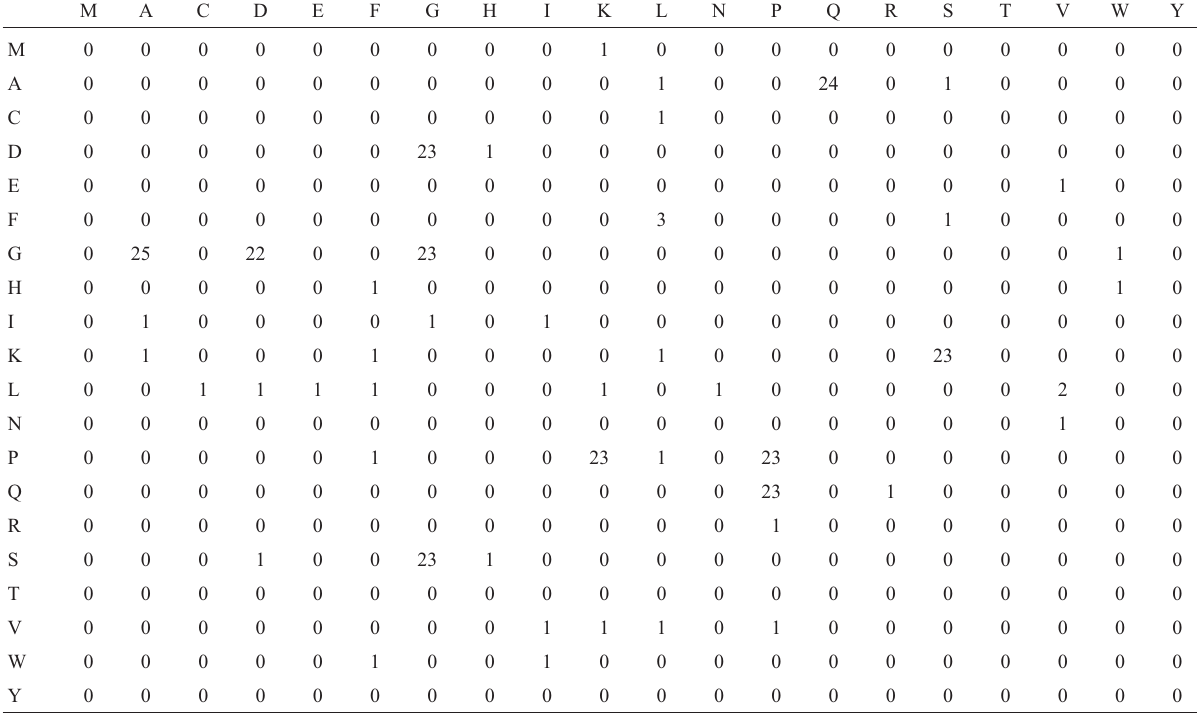
Table 2 - Image matrix.